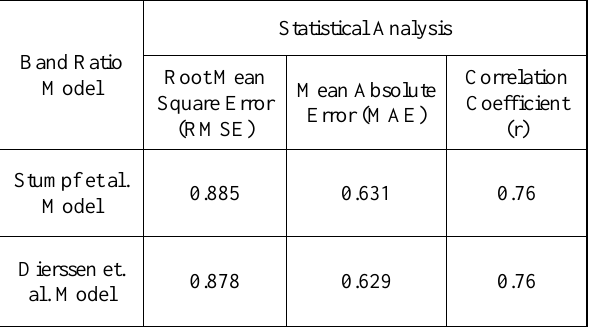
Table 1. Statistical results based on the Stumpf et al.’s model and Dierssen et al.’s